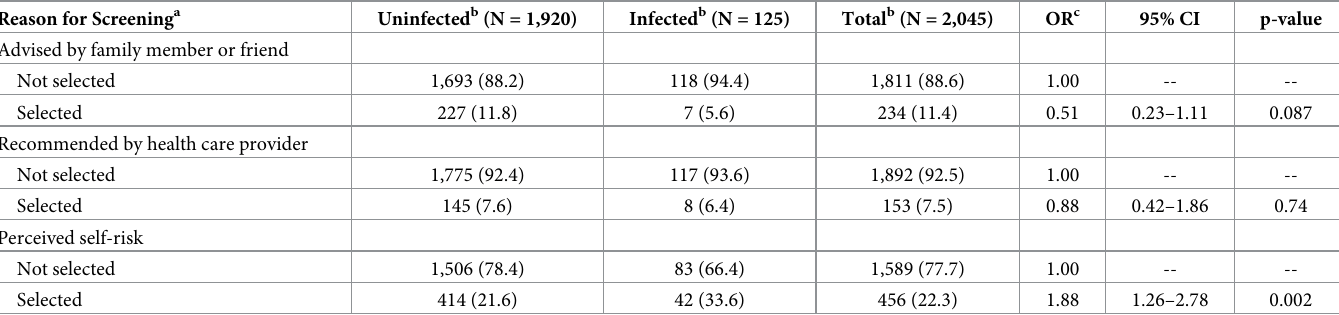
Table 3. Association between screening motivations and HCV infection among only participants who reported their reason for